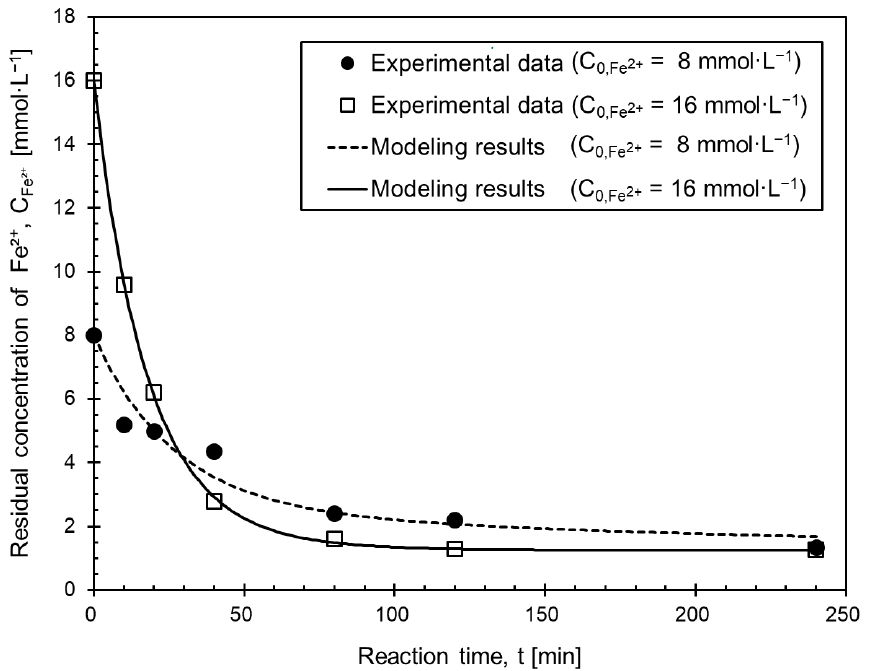
Figure 8. Experimental and modeling results of the ferrous oxalate precipitation behavior for initial concentrations of ferrous ions ( 𝐶 0,𝐹𝑒 2+ ) of 8 ( ● ) and 16 ( □ ) mmol·L⁻ 1 , by using ferrous ammonium sulfate system at 𝐶 𝑂𝐴 = 60 mmol·L⁻ 1 and 25 °C.